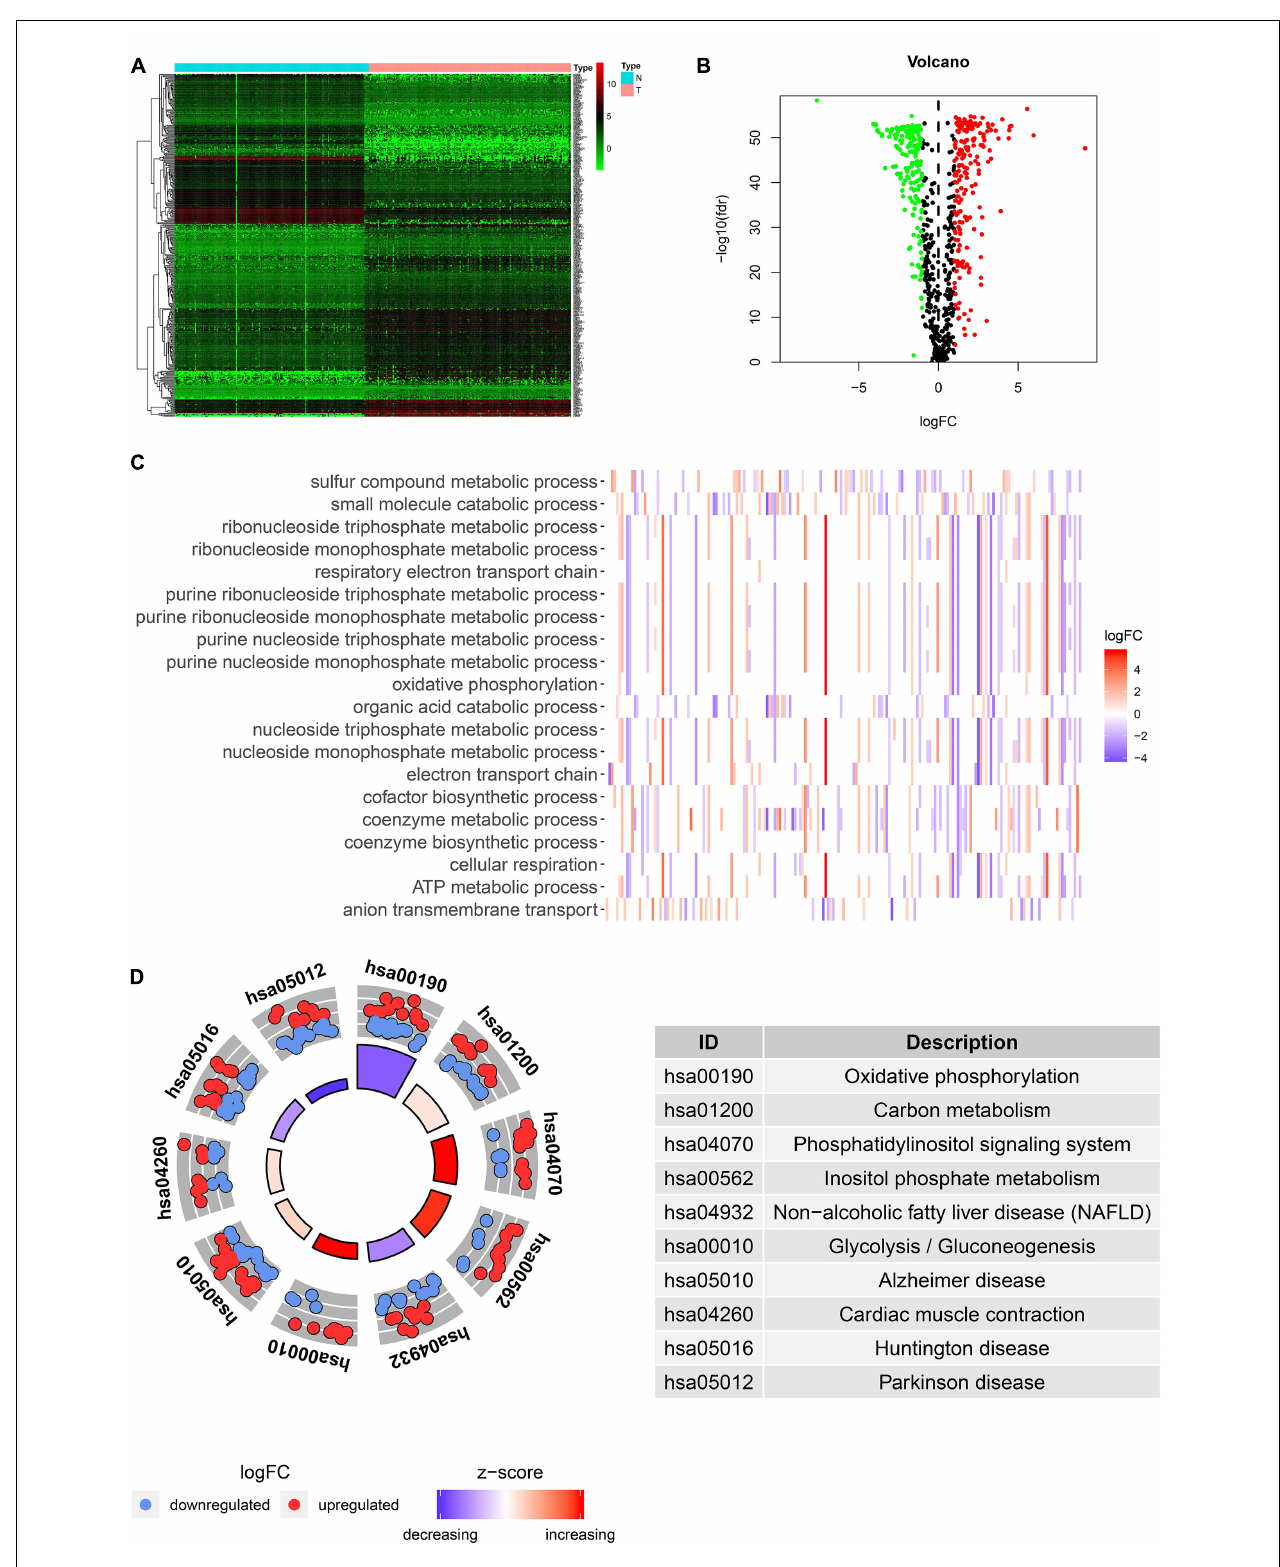
FIGURE 2 | Identification and functional enrichment analysis of differentially expressed metabolic-related genes (DEMRGs). (A) Heat map, volcano map, and boxplot of DMRGs. (B) Gene Ontology (GO) enrichment analysis of DMRGs. (C,D) Kyoto Encyclopedia of Genes and Genomes (KEGG) enrichment analysis of DMRGs.